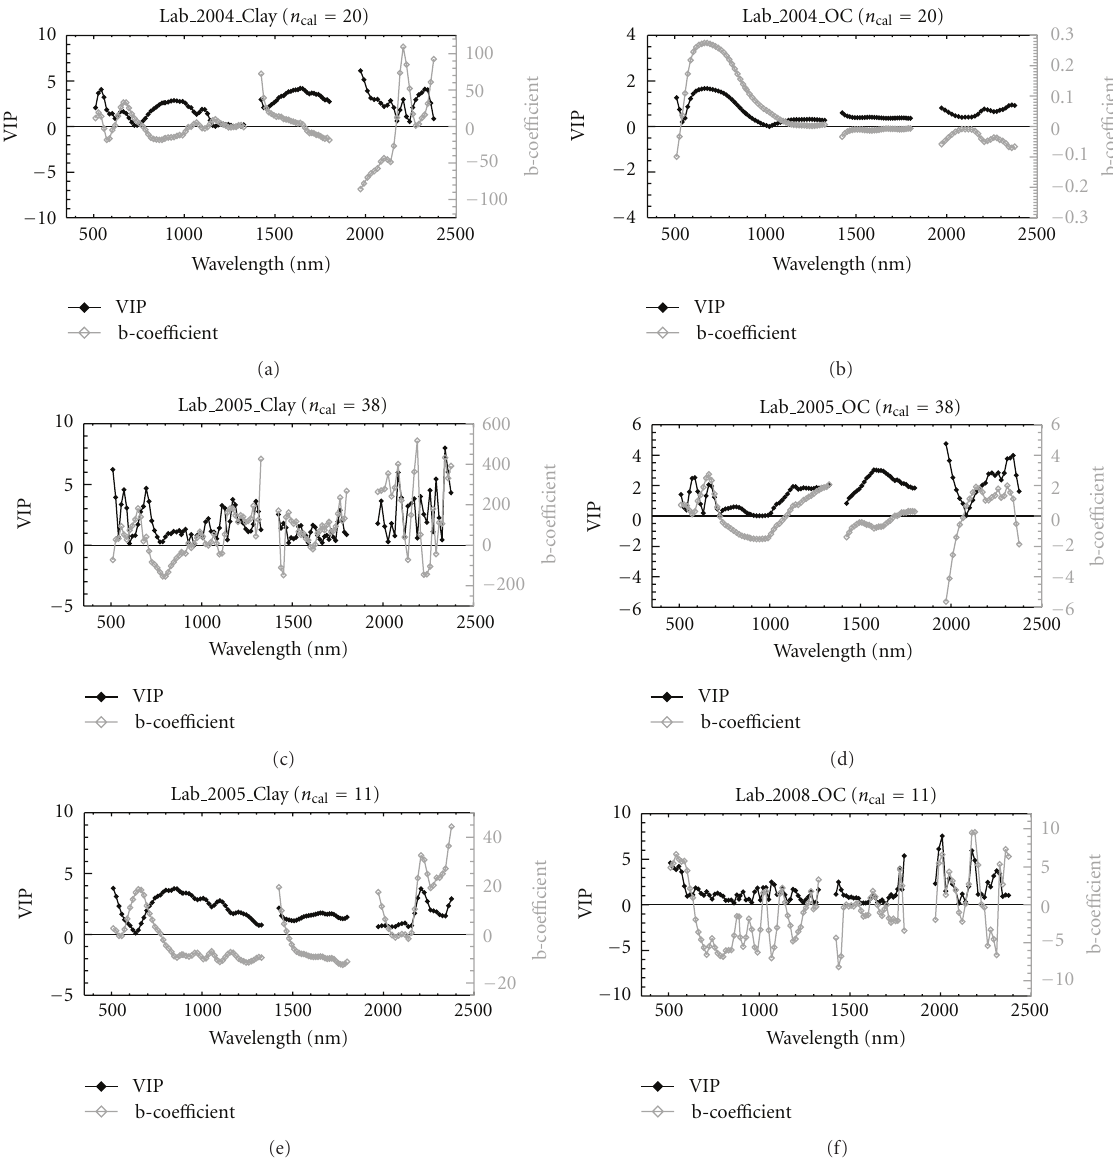
Figure 9: Variable importance in the projection (VIP) and b -coe ffi cients of PLSR calibration models based on laboratory spectra using 20, 38, and 11 soil samples for clay (left side) and organic carbon (right side).